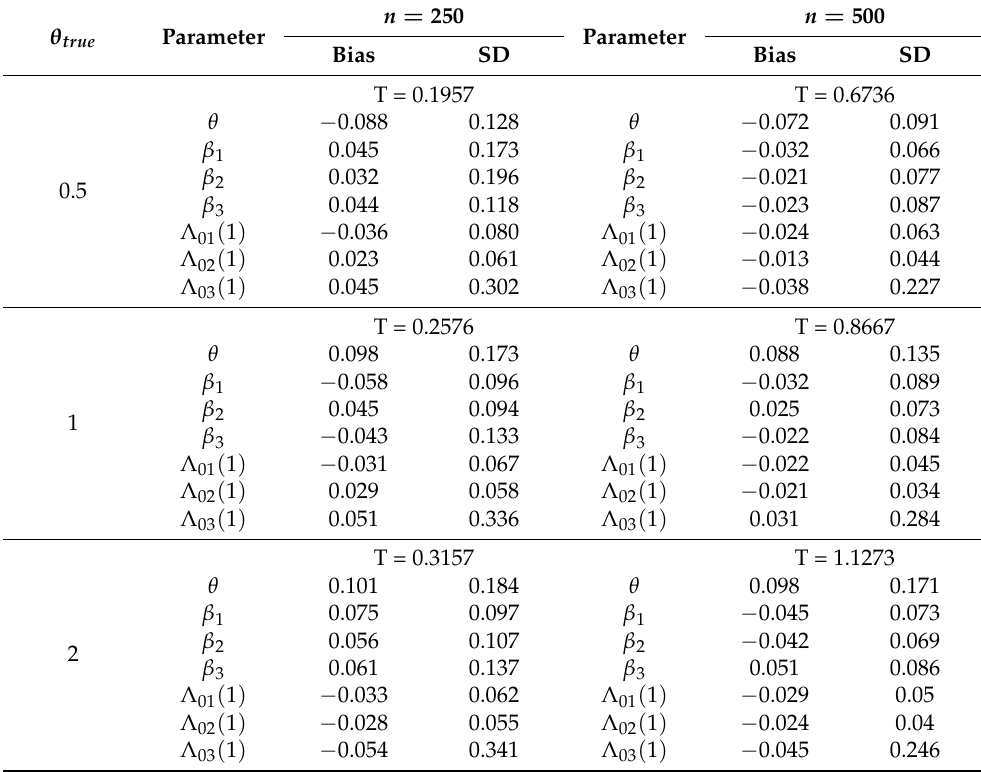
Table 1. The simulation results of the illness–death model with gamma frailty at 30% censoring proportion.